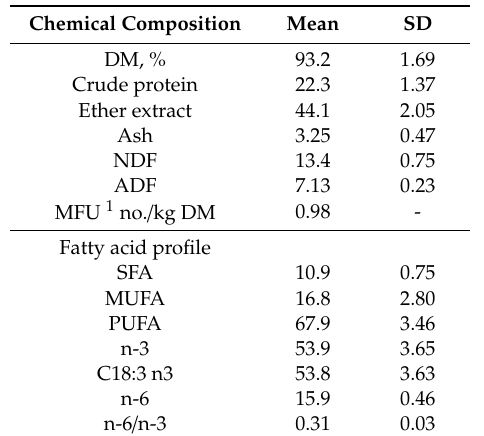
Table 2. Descriptive statistics (mean ad standard deviation, SD) for chemical composition (% on DM basis) and fatty acid profile (% of total FA) of the flacked flaxseed used in the study (n = 7